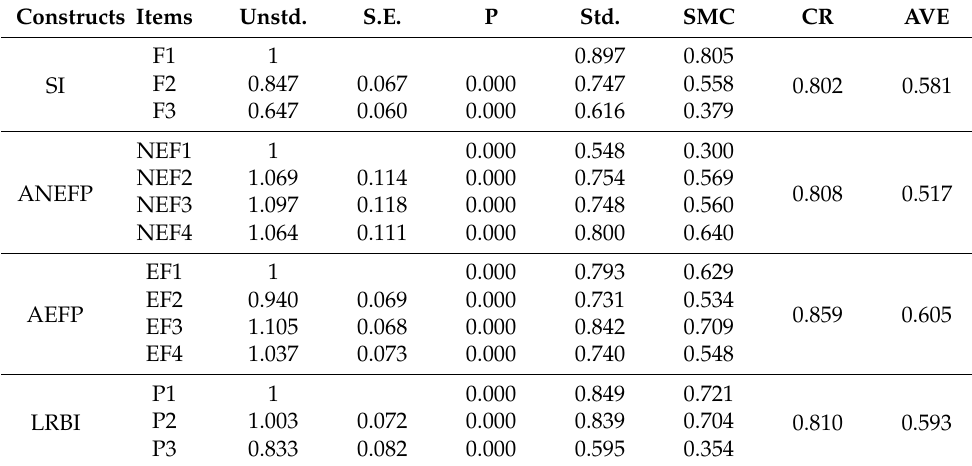
Table 3. Structural validity test of the measurement